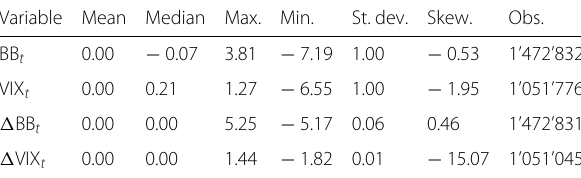
Table A5 Descriptive statistics for BB t , VIX t , (cid:2) BB t , and (cid:2) VIX t Variable Mean Median Max.